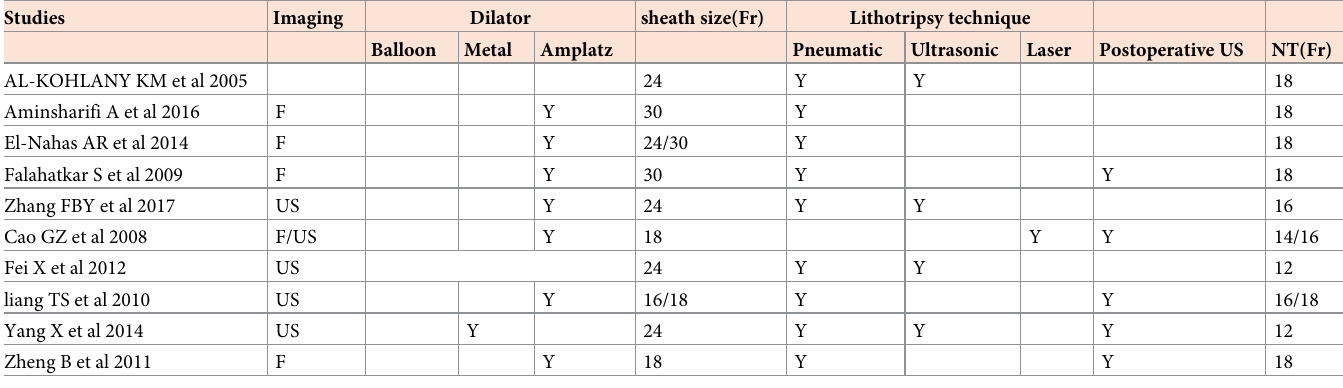
Table 2. Variations in PCNL techniques, as stated in the methods section: An